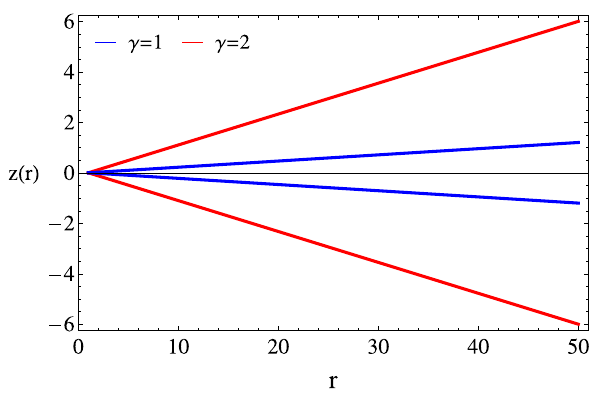
Fig. 4 The figure shows 2-dimensional wormhole embedding diagram for the model #2. The vertical axis has been re-scaled by a factor 10